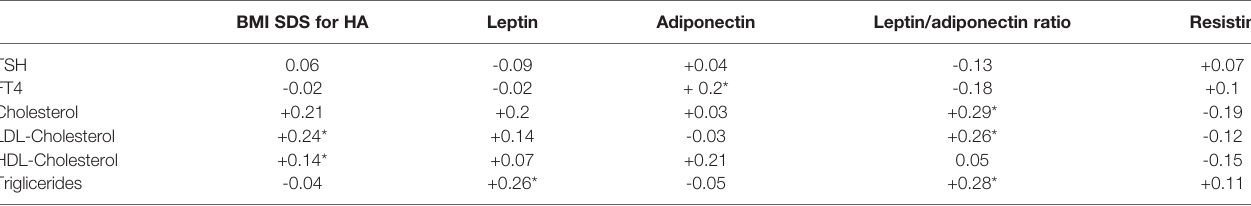
TABLE 2 | The correlation of TSH, FT4 and lipids concentration with BMISDS and selected adipocytokines. BMI SDS for HA Leptin Adiponectin Resistin